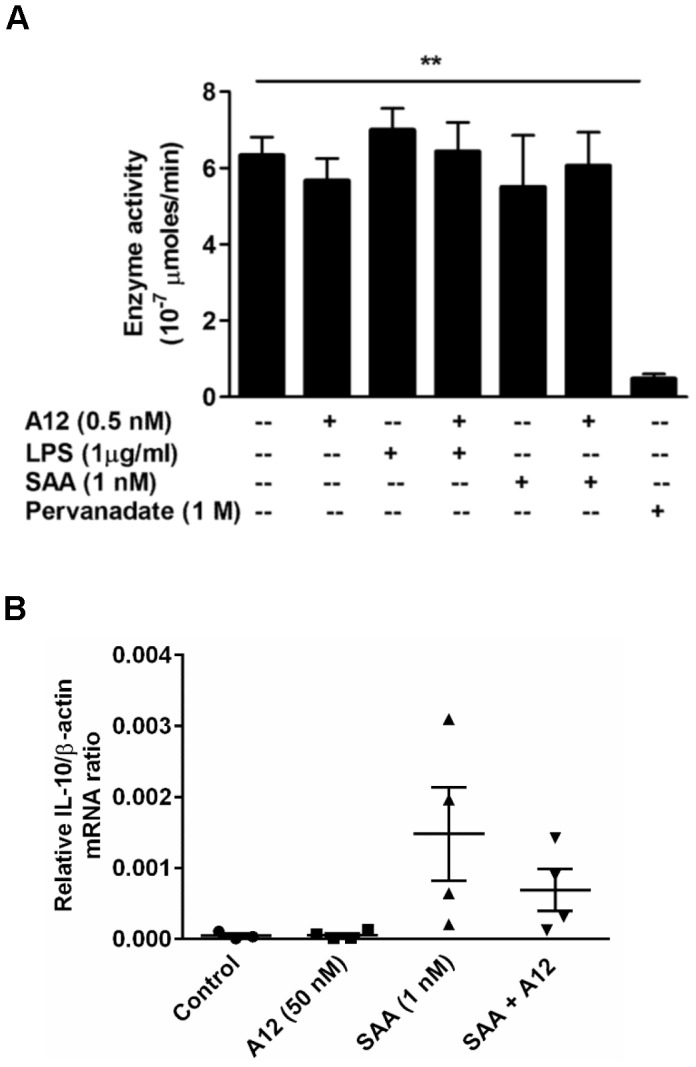
S100A12 did not alter total phosphatase activity or IL-10 mRNA induction.(A) pNPP phosphatase assay using THP-1 cells lysates treated with SAA (1 nM) ± S100A12 (0.5 nM), or LPS (1 µg/ml) ± S100A12 (0.5 nM) was performed. Pervanadate (1 M)-treated THP-1 cell lysates were included as positive control. Values represent means ± SEM of duplicate assays from three independent experiments; **p<0.01 compared to untreated cells (analyzed by one-way ANOVA with Bonferroni’s correction for multiple comparison tests). (B) PBMC treated with SAA (1 nM), S100A12 (50 nM) or SAA ± S100A12 for 4 h, and IL-10 mRNA quantitated by real-time RT-PCR; β-actin mRNA served as endogenous control. Data represent means (relative to β-actin mRNA) ± SEM of duplicate measurements from four independent donors (analyzed by paired t-test).